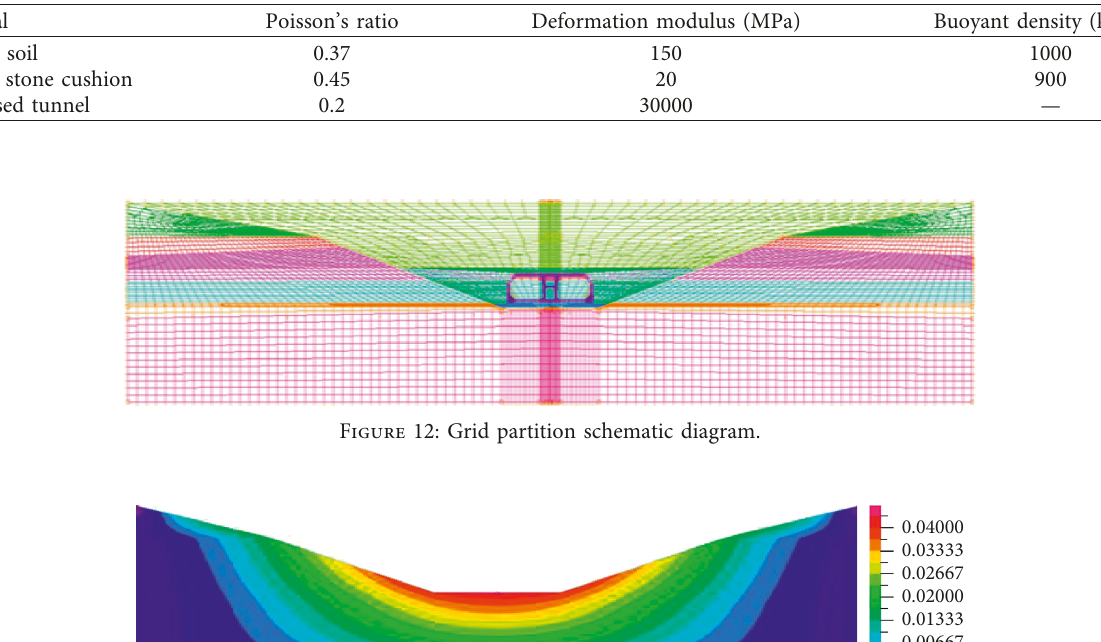
Table 5: Calculation parameters.